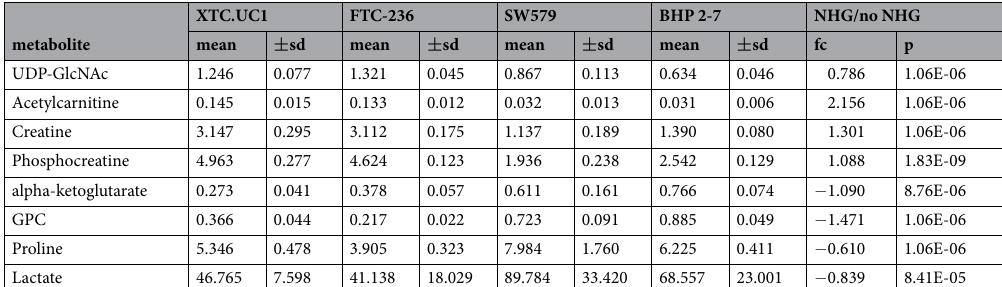
Table 1. Concentration ( µ M/10 6 cellls ± sd) of intracellular metabolites that exhibited similar levels in NHG vs no NHG showing TC